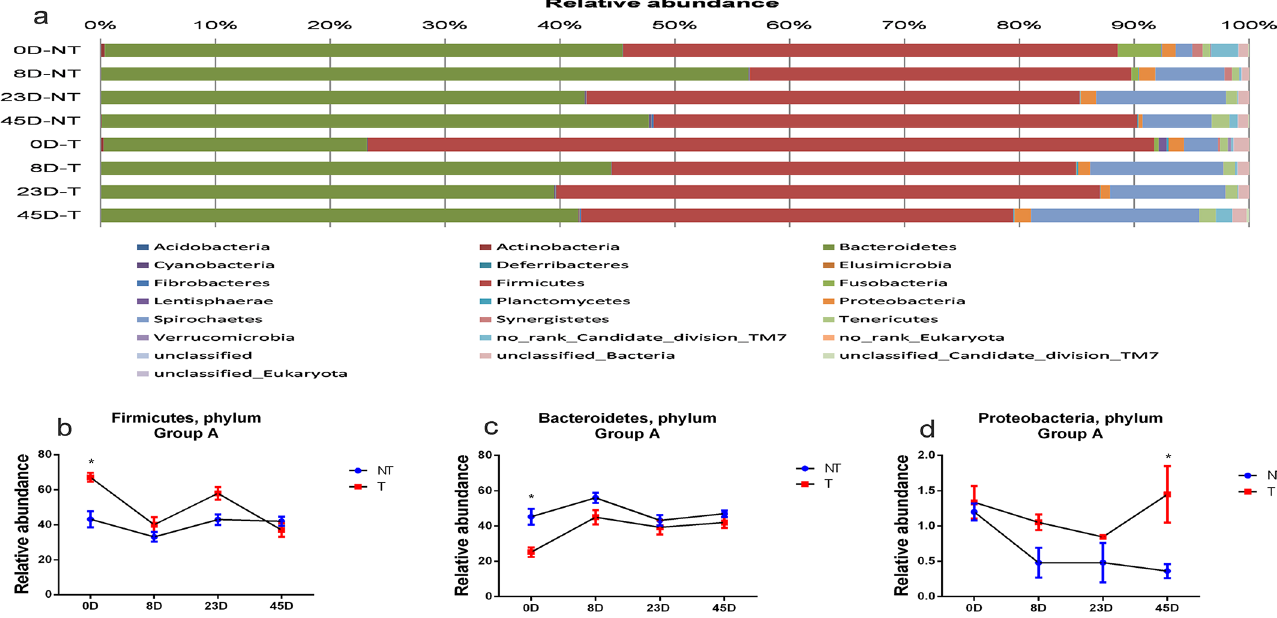
Fig 3. Different patterns in changes in phylum level between transgenic and non-transgenic pigs post neomycin feedings in Group A. Comparison of the relative abundance of bacterial phyla (a) in fecal samples collected from the rectums of transgenic and non-transgenic pigs at various time points (0D, 8D, 23D and 45D) post neomycin feeding; comparison of changes in the levels of Firmicutes (b), Bacteroidetes (c), and Proteobacteria (d) at various time points (0D, 8D, 23 and 45D) post neomycin feeding between transgenic (T) and non-transgenic (NT) pigs in Group A. * : P < 0.05.